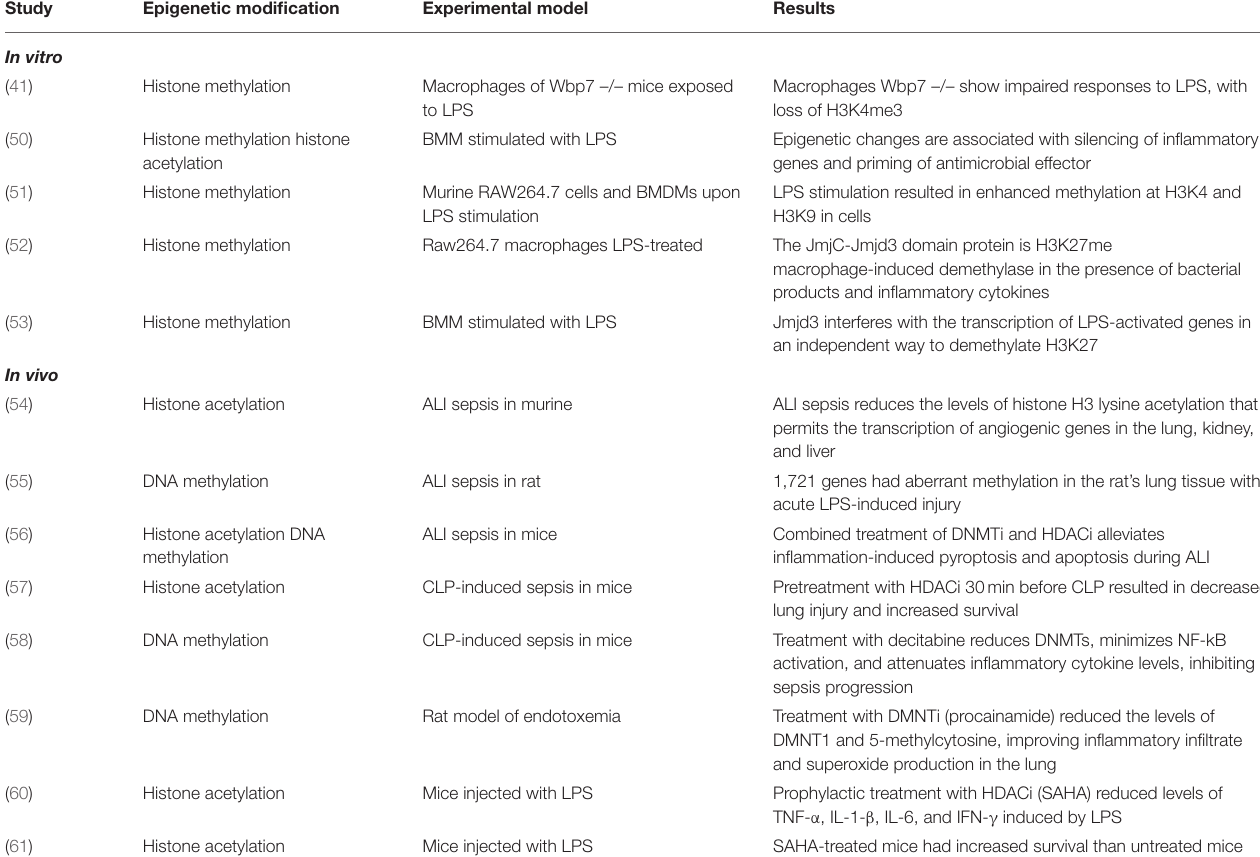
TABLE 2 | In vitro and in vivo experimental studies evaluating epigenetic modifications in LPS challenge and